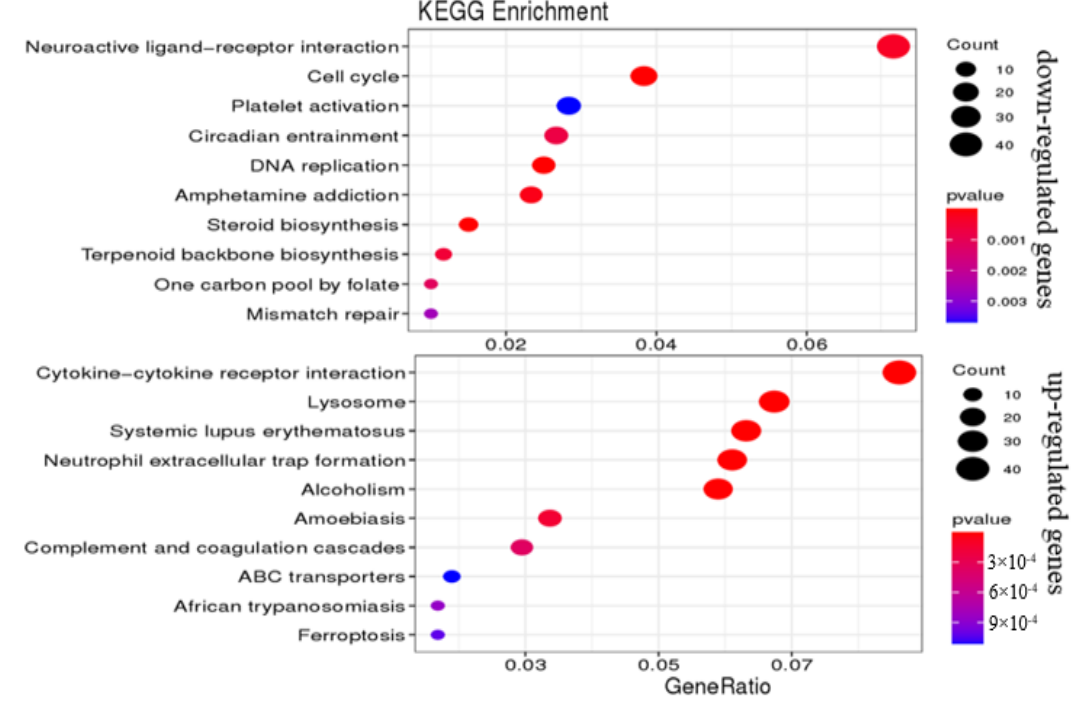
Figure 5. GO and KEGG functional enrichment analysis of DEGs in the skin.